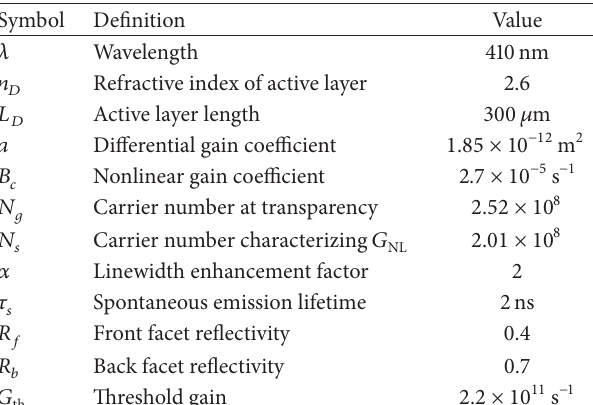
Table 1: Definition and numerical values of the InGaN laser parameters.